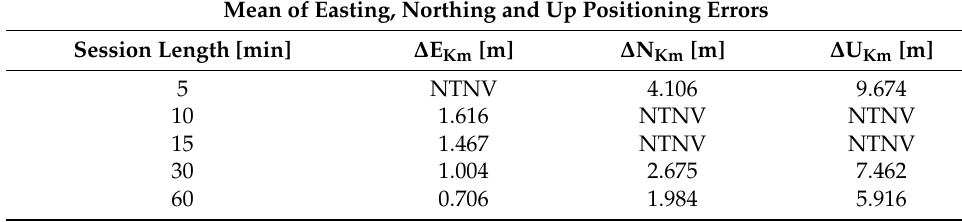
Table 12. Mean of Easting, Northing and Up SPP errors for ∆ E Km , ∆ N Km , ∆ U Km . Mean of Easting, Northing and Up Positioning